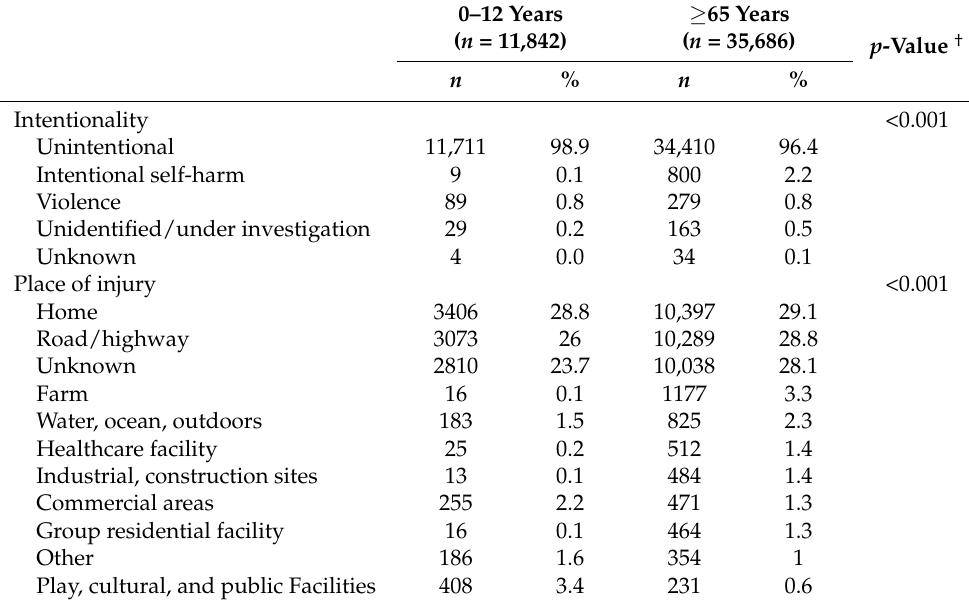
Table 2. Injury characteristics in the children and elderly